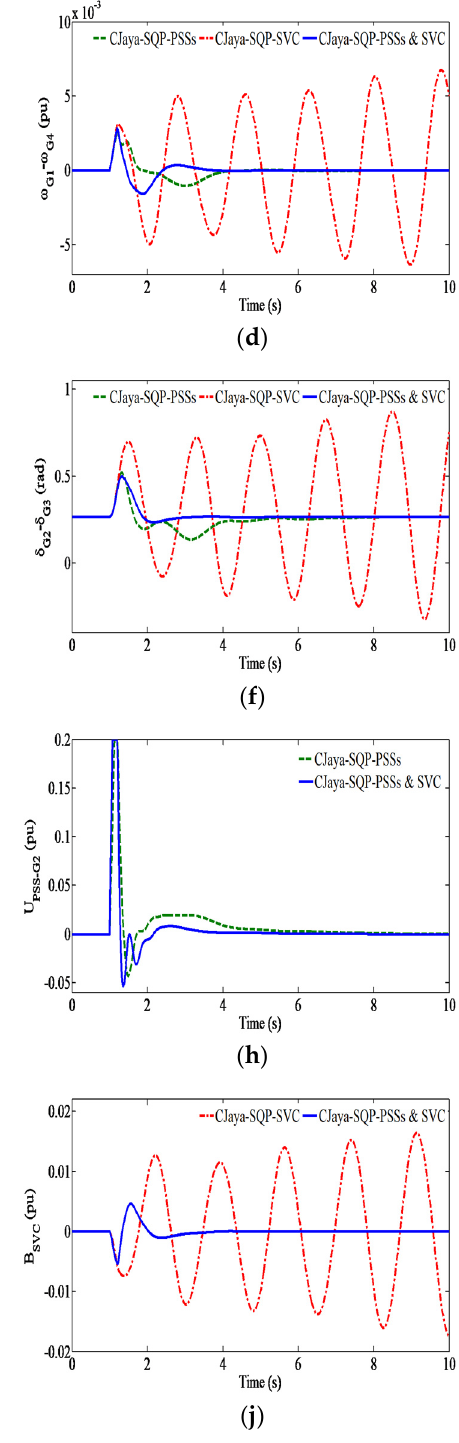
Figure 18. Power system dynamic responses for scenario II : ( a ) Speed deviation response of G1-G2; ( b ) Speed deviation response of G3-G4; ( c ) Speed deviation response of G1-G3; ( d ) Speed deviation response of G1-G4; ( e ) Rotor angle response of G1-G3; ( f ) Rotor angle response of G2-G3; ( g ) PSS output signal response at generator G1; ( h ) PSS output signal response at generator G2; ( i ) PSS output signal response at generator G4; and ( j ) SVC susceptance response.